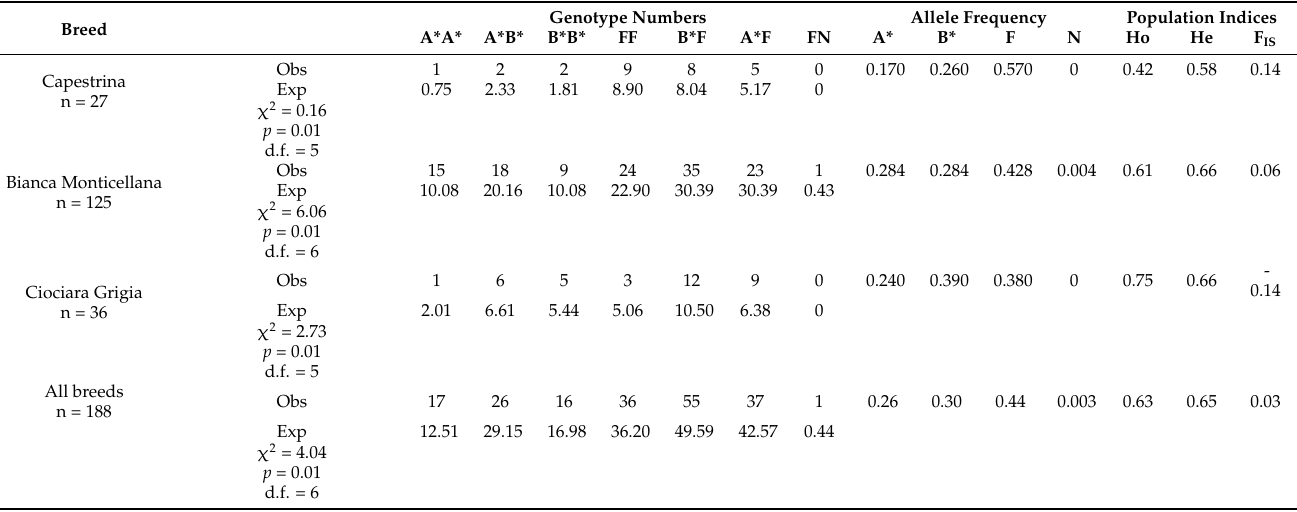
Table 1. Genotype numbers (observed and expected), allele frequencies, and population indices observed at the CSN1S1 locus in Capestrina, Bianca Monticellana, and Ciociara Grigia populations. Breed